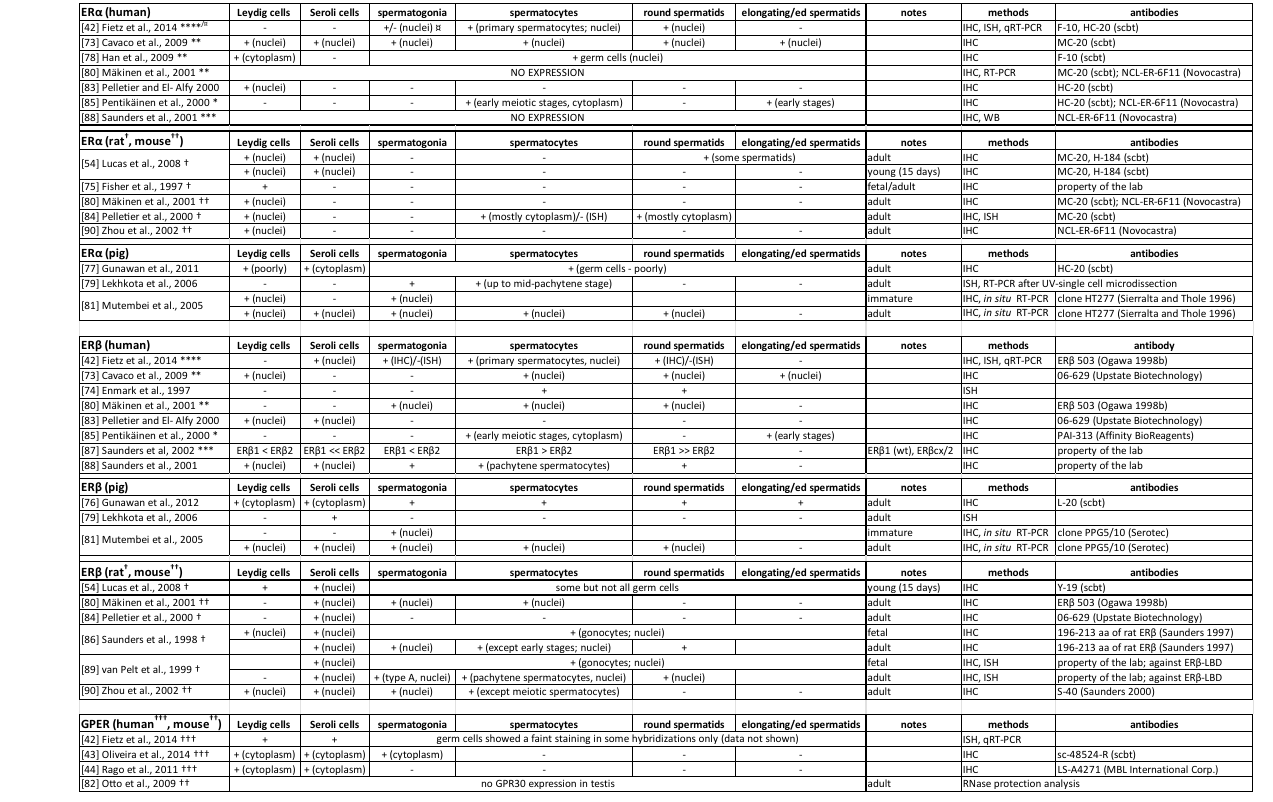
Figure 2. Oestrogen receptor localization in the testis. The Figure summarises up-to-date information on the localization of ER α , ER β and GPER in human, pig, rat and mouse testicular cells. * Elderly men (60–80 years old) undergoing surgery due to prostatic cancer; ** azoospermia, maturation arrest, Sertoli cell-only; *** azoospermia, vasectomy; **** azoospermia, patients undergoing vasectomy; ¤ positive or negative ER α detection in spermatogonia depending on the approach used: IHC—positive staining with HC-20 antibody, negative staining with F-10 antibody, ISH—positive; † rat; †† mouse; ††† human; IHC—Immuno Histo Chemistry; ISH—In Situ Hybridization; qRT-PCR—quantitative Reverse Transcription Polymerase Chain Reaction; WB—Western Blot detection; scbt—Santa Cruz Biotechnology.